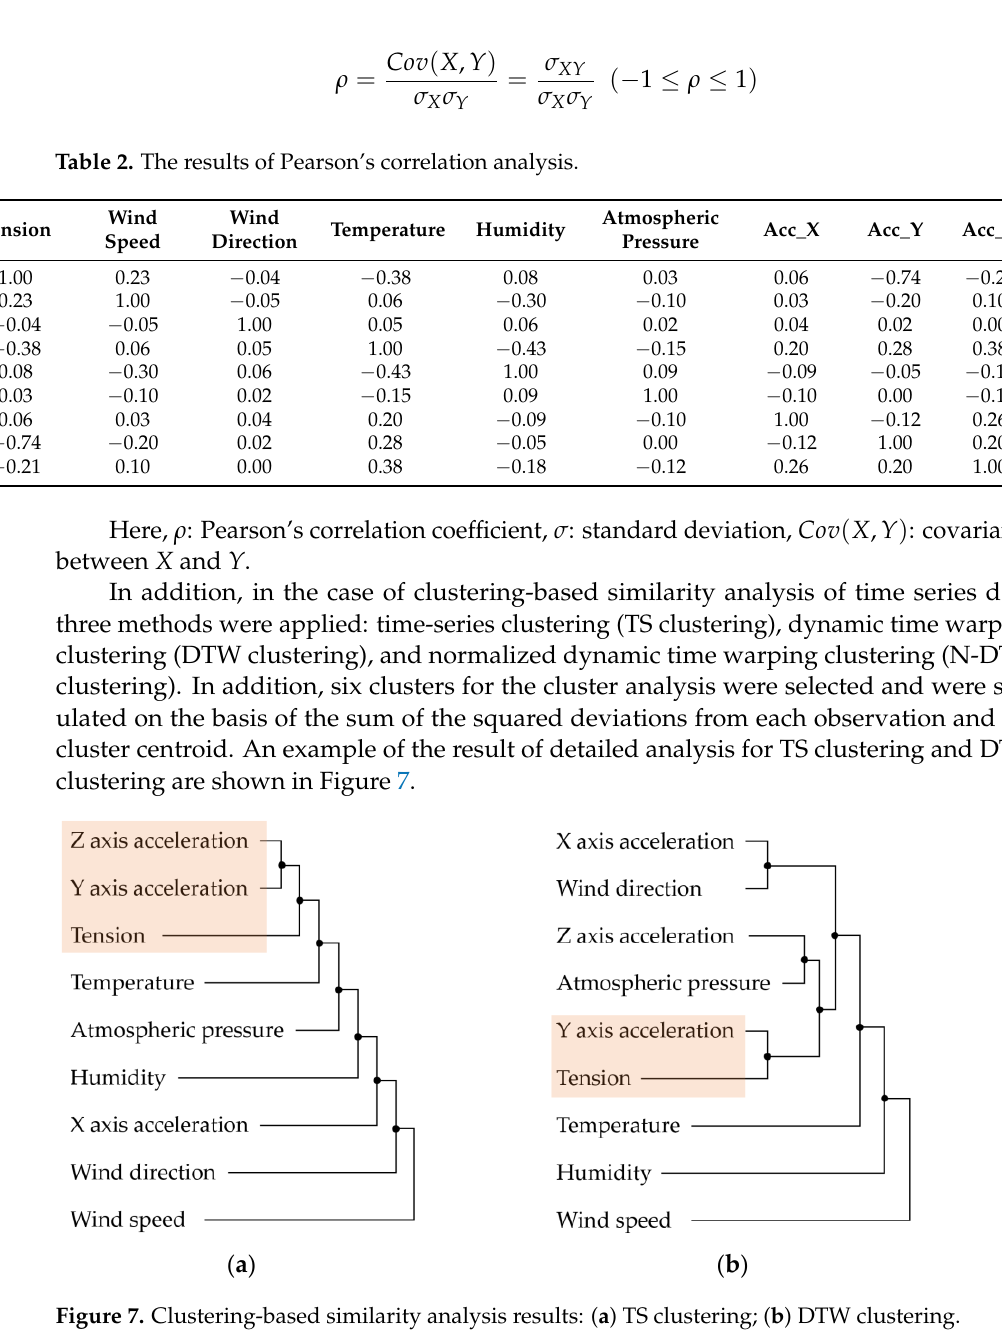
Table 2. The results of Pearson ’ s correlation analysis.